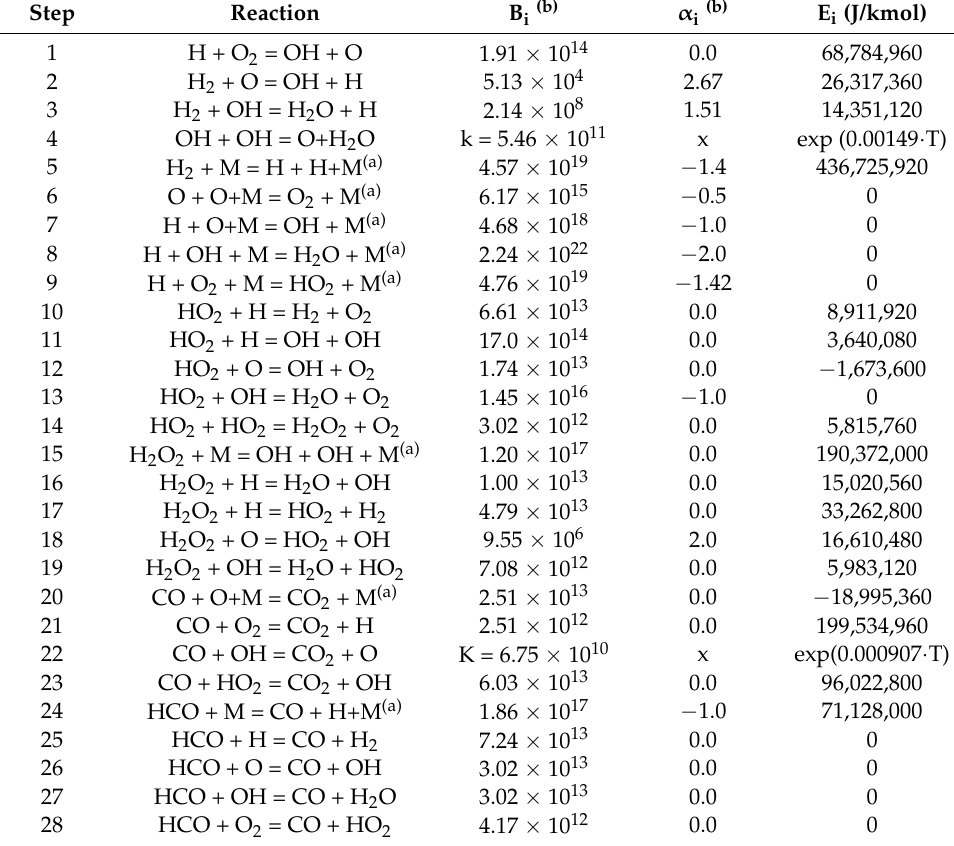
Table 2. Homogeneous rate constants of the CO/H 2 O/O 2 reaction mechanism (from Chelliah, Chelliah et al. and Yetter et al. [30,31,33]) in the form k i = B i T α i exp ( − E i / RT ) . Units are J, kmol, cm and